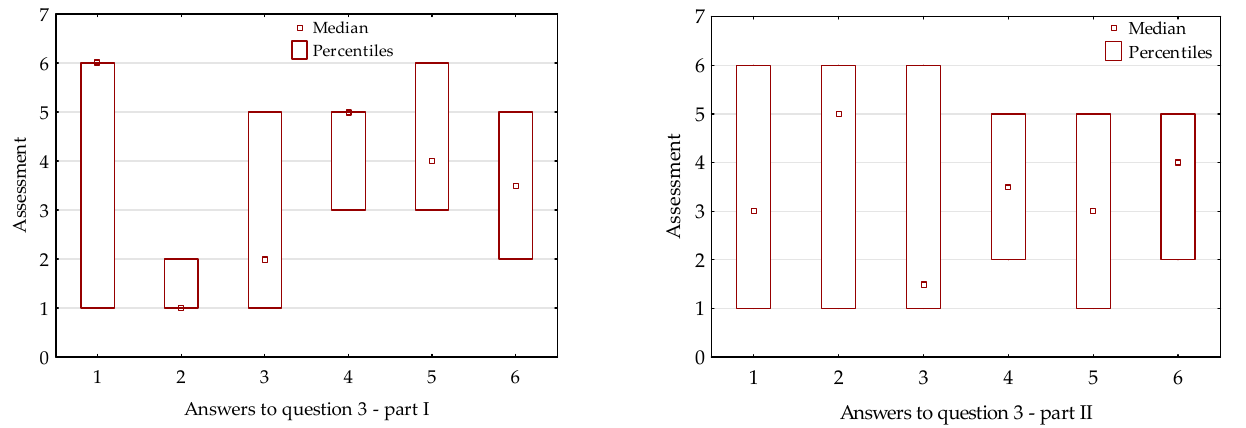
Figure 3. Box-whisker charts for the mean ranks of the assessed answers in question 3 for the accuracy of answers criterion ( part I ) and the criterion of the answer structure ( part II ).